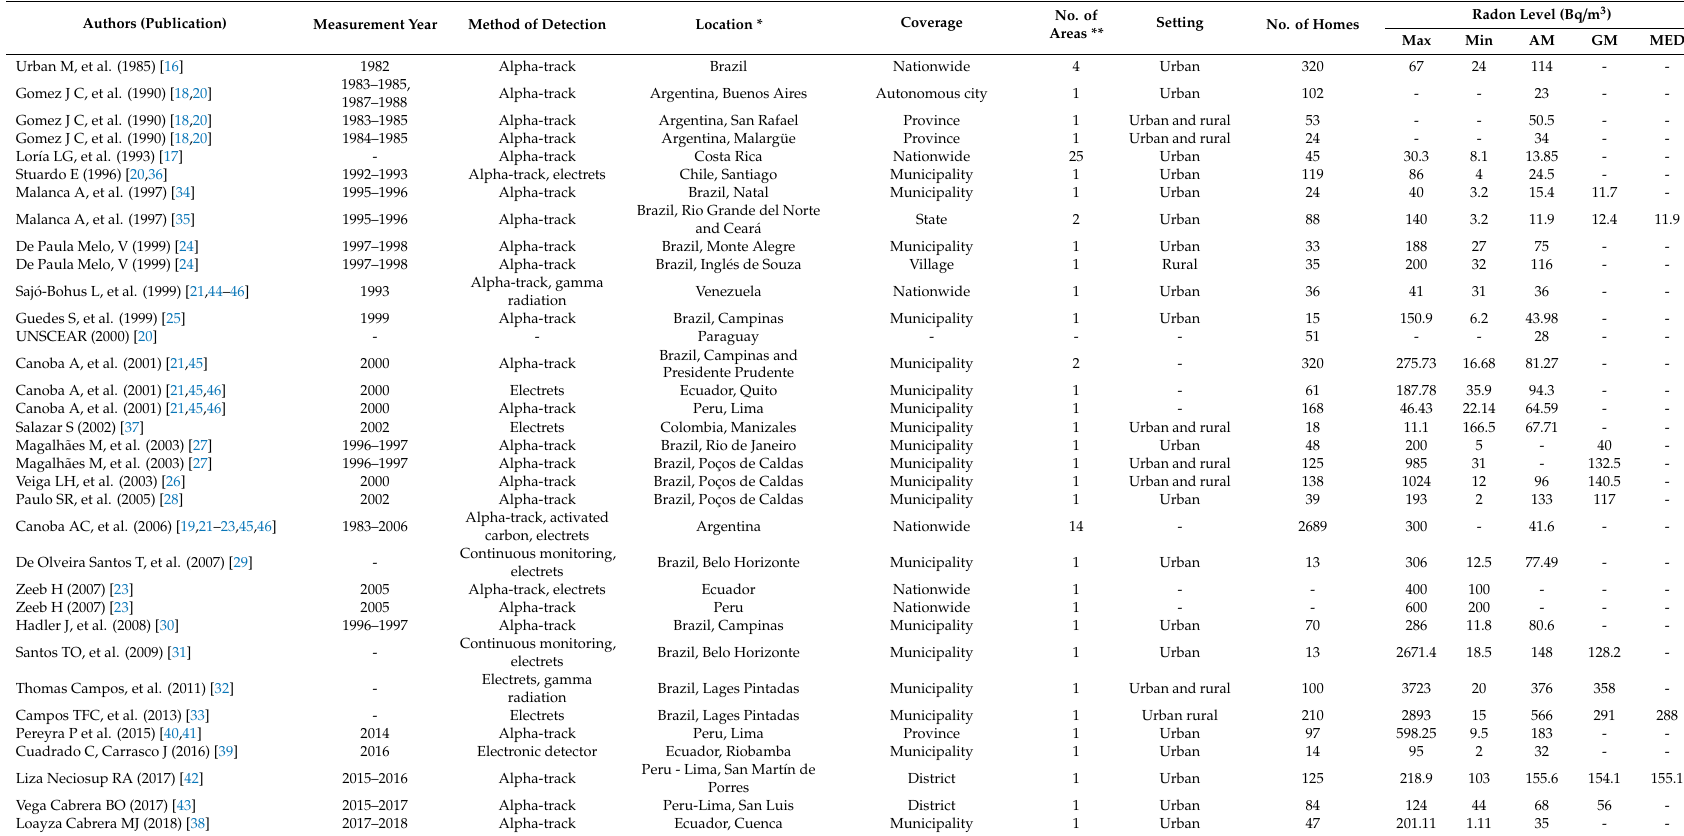
Table 1. Description of radon measurement studies in Central and South American